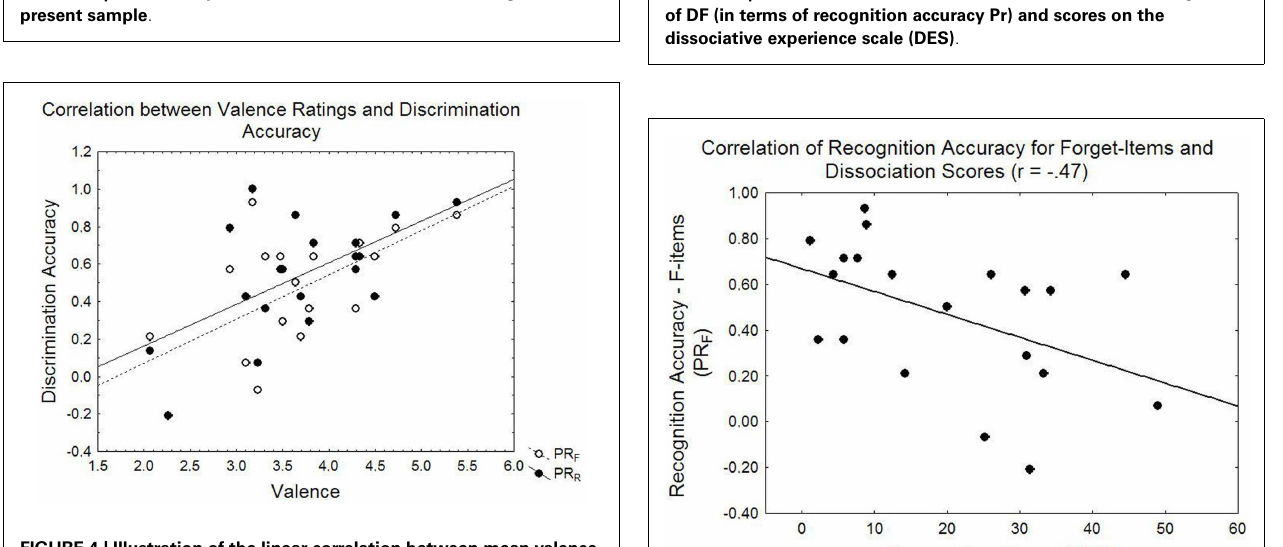
FIGURE 4 | Illustration of the linear correlation between mean valence ratings and discrimination accuracy (Pr) . For valence ratings, higher numbers indicate more positive ratings.